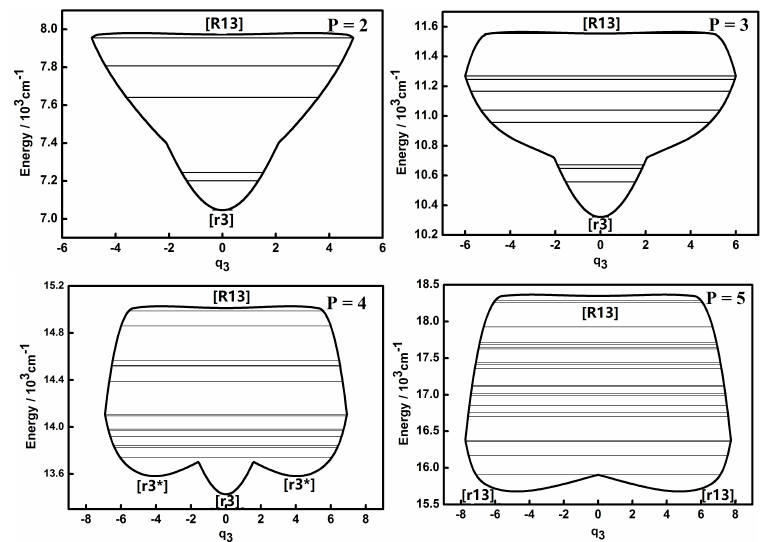
Figure 3. Dynamic potentials of the non-integrable HOCl system (obtained with H ( q 2 ,p 2 ,q 3 ,p 3 ,P ) , q 2 coordinate) with P = 2, 3, 4, 5, and the energy levels included in the dynamic potential are shown by the lines.